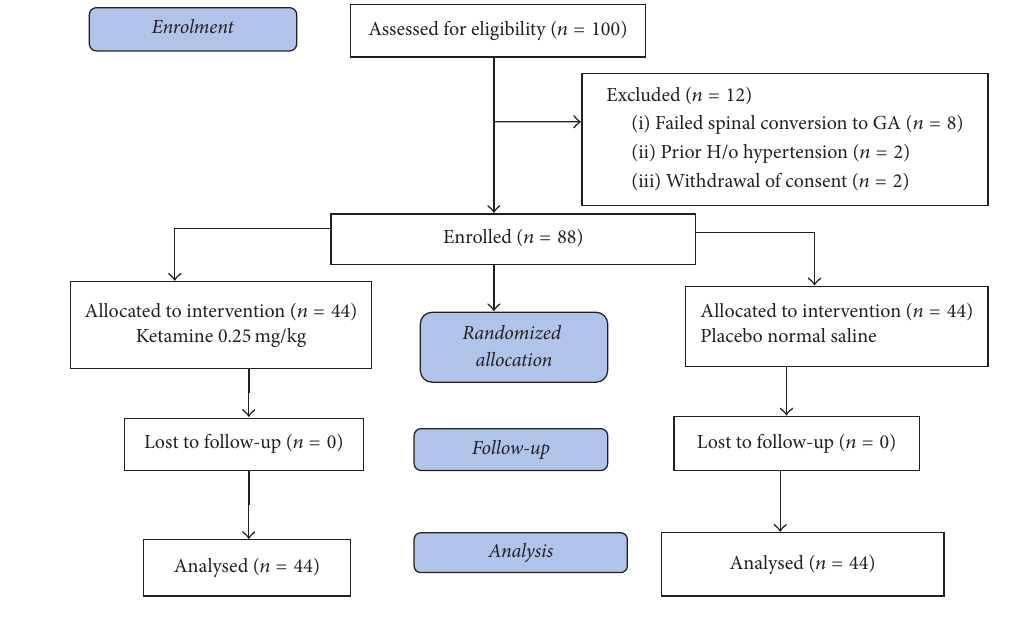
Figure 1: Flow chart and numerical scale. Table 1: Patients’ demographics.